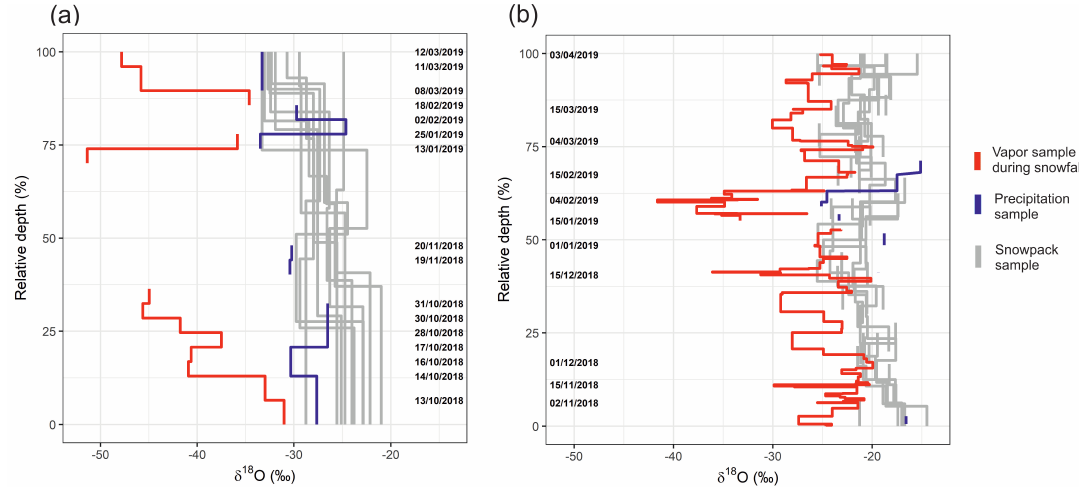
Figure 9. Accumulated vapor δ 18 O composition (red) during days with snowfall and accumulated precipitation δ 18 O profiles (blue) superimposed on the snowpack δ 18 O profiles (gray). Gaps in the precipitation and vapor records are indicative of snowfall events in the meteorological record, which were not sampled. Dates on the vertical axes for ( a ) Imnavait specify days when precipitation or vapor samples were collected and for ( b ) Pallas indicate the timeline of snow accumulation and vapor sampling approximately every two